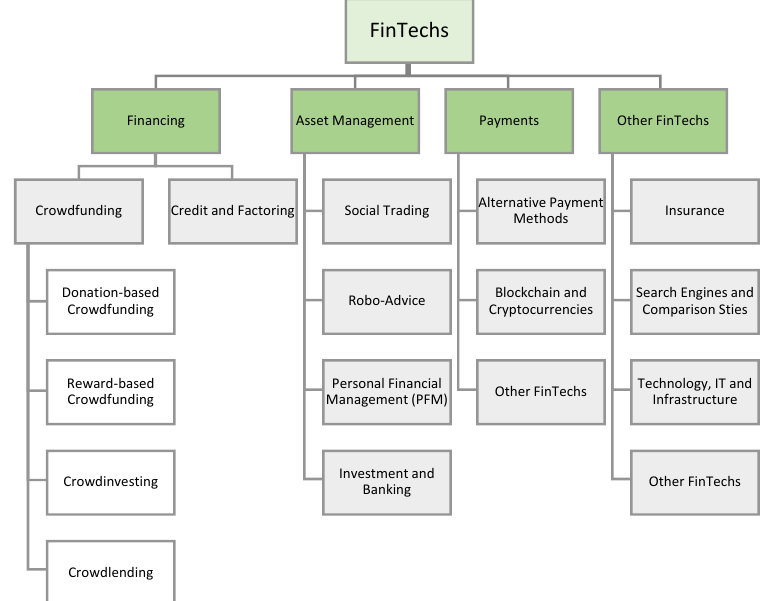
Figure 1. Segments and elements of FinTech (source: Suseendran et al. (2020), Banking and FinTech (Financial Technology) Embraced with IoT Device, Figure 5, in Data Management, Analytics and Innovation , page 205. Copyright 2020 by Springer Nature, with permission).